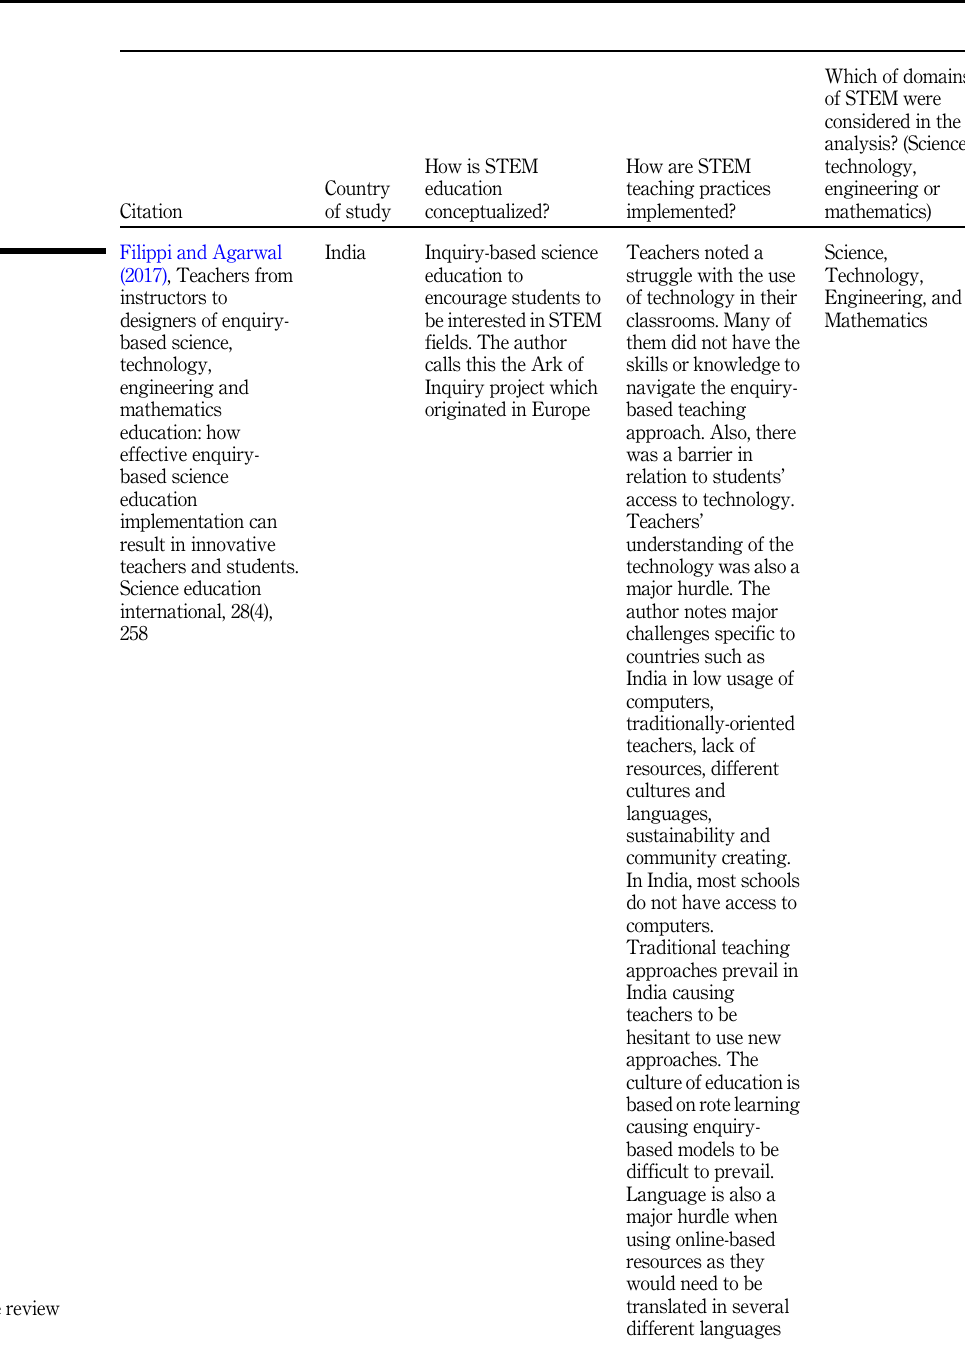
Table 1. Literature review